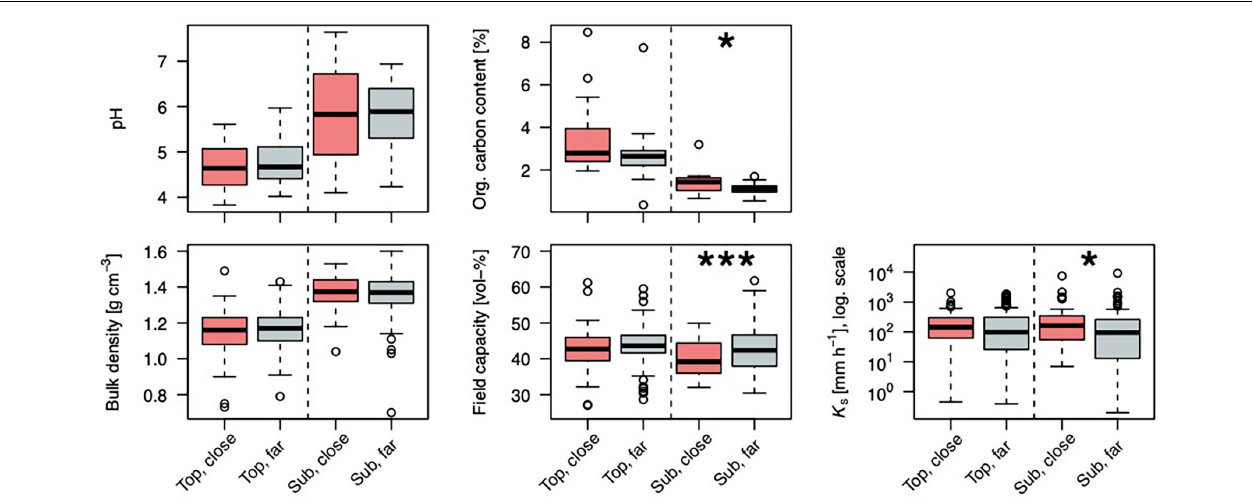
FIGURE 6 | Distributions of soil properties for locations in the topsoil (5–10 cm depth, “top”) and the subsoil (25–30 cm depth, “sub”) close to trees ( < 1 m distance to a stem, “close”) or further from trees ( > 1 m distance to a stem, “far”), n (close:far) in order or appearance: 63:136, 62:136, 64:136, 60:122, 19:31, and 19:30. Asterisks mark a significant difference between tree-close and tree-far samples. Field capacity: soil water content at − 60 hPa; K s : saturated hydraulic conductivity. Levels of significance: ∗∗∗ p < 0.001, ∗ p < 0.05.